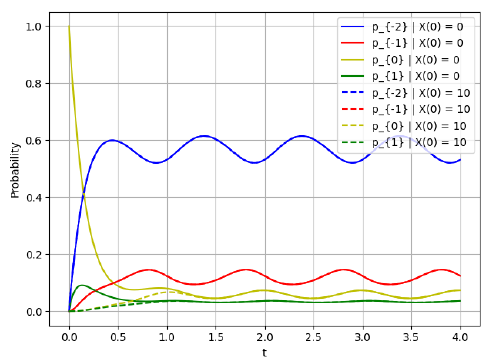
Figure 7. Probability p − 2 ( t ) , p − 1 ( t ) , p 0 ( t ) , p 1 ( t ) for t ∈ [ 0,4 ] ; this figure shows the rate of convergence for N =